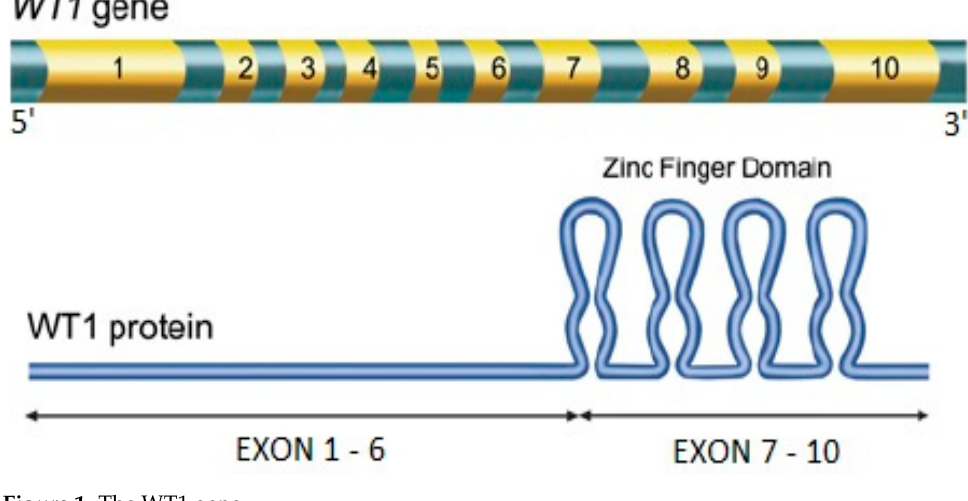
Figure 1. The WT1 gene.